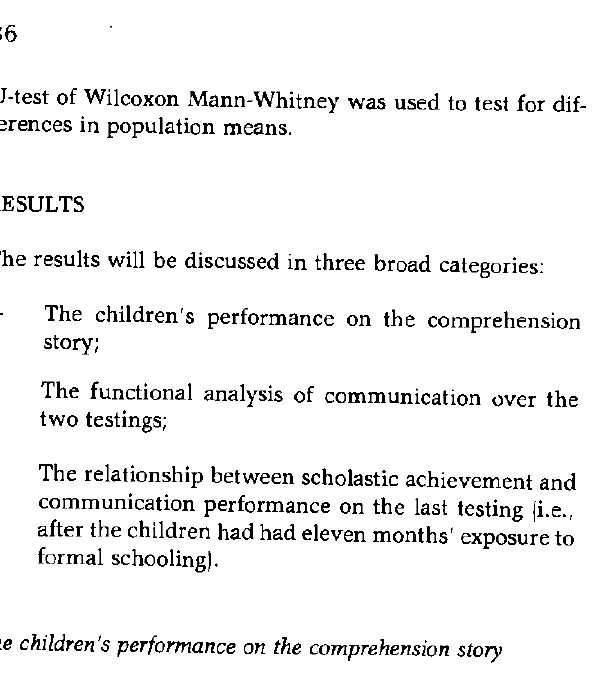
Table 2: Test for difference in means with respect to accuracy of response and probing needed to